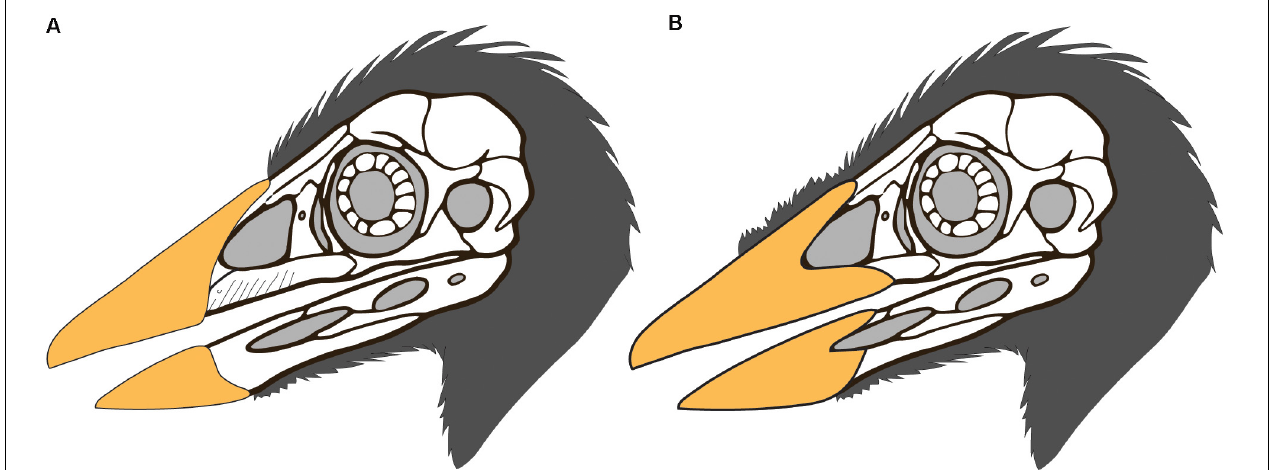
FIGURE 5 | Possible reconstructions of the skull integument in Confuciusornis (skull drawing modified from that of S. Abramowicz): (A) the rhamphotheca is limited to the premaxilla as in neornithines, and the cranial feathers extend only as far rostrally as the rhamphotheca; (B) the upper rhamphotheca is reconstructed extending along the premaxillary process of the maxilla and the dorsal cranial feathers are reconstructed extending rostrally, possibly medially between the two halves of the rhamphotheca as suggested by STM13-133.